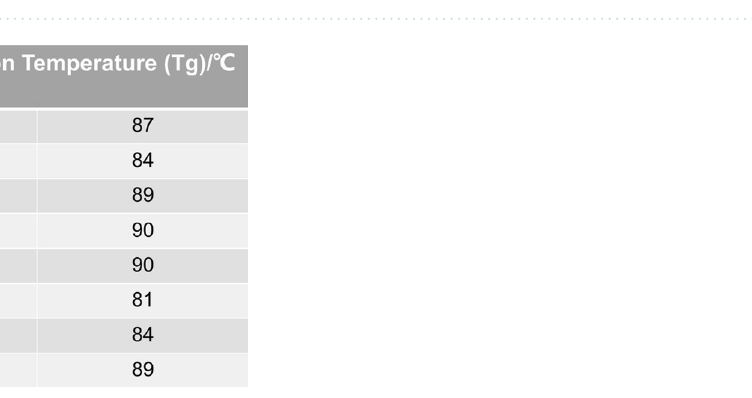
Figure 15. ( a ) DSC spectra of the neat epoxy (black) and Si-BaTiO 3 -Epoxy nanocomposite samples at 5 wt.% (Red), 10 wt.% (Blue), and 15 wt.% (Pink), ( b ) Tg temperature as a function of weight loading of Si-BaTiO 3 (Red) and untreated BaTiO 3 (Black) of the epoxy nanocomposites samples.